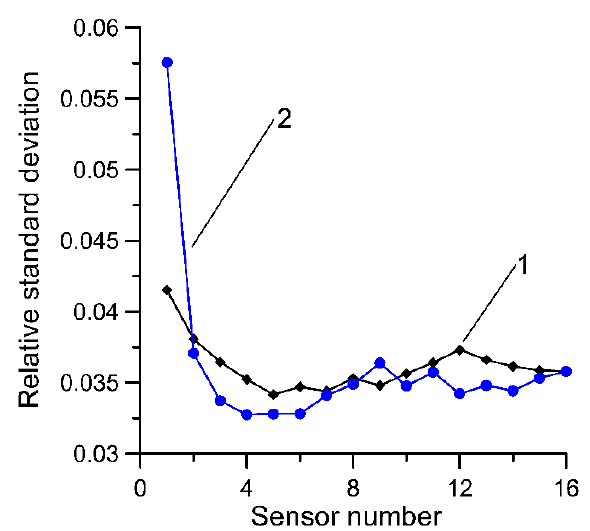
Figure 6. Dependency of the relative standard deviation of weighing results for GVW obtained for Equation (7) as a function of the number of load sensors. 1—weighing results averaged in order of increasing uncertainty of the results, 2—weighing results of successive load sensors averaged in the order in which the sensors were installed.